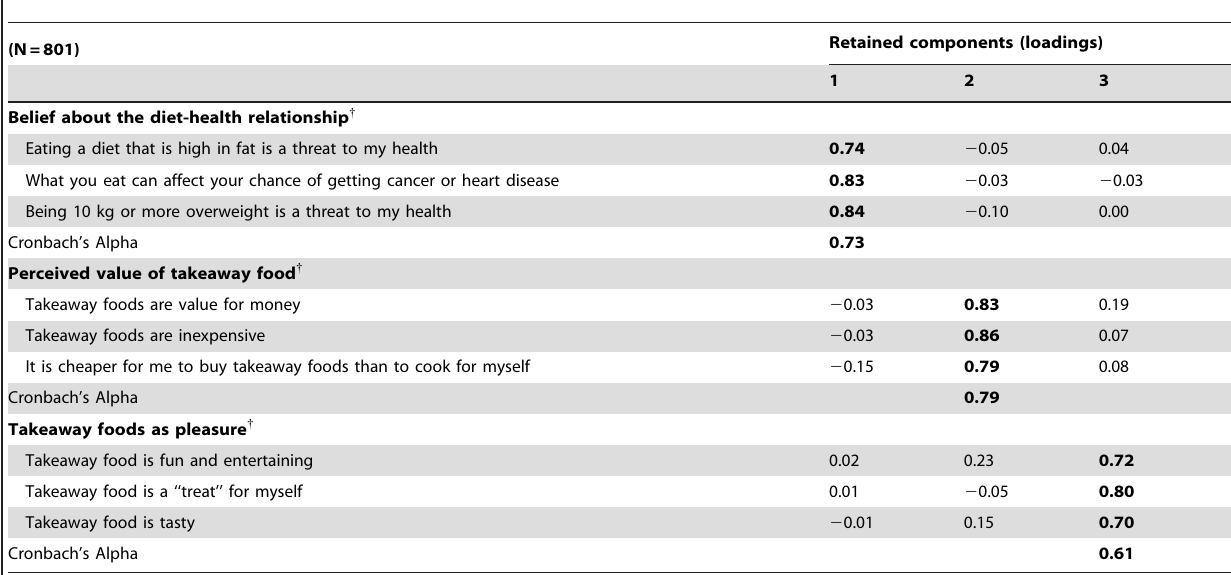
Nutritional knowledge: A 20-item nutritional knowledge mea-